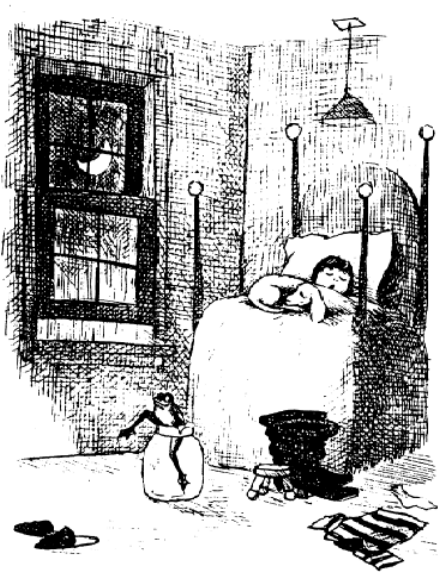
Figure 1: Sample picture used in the semi-production